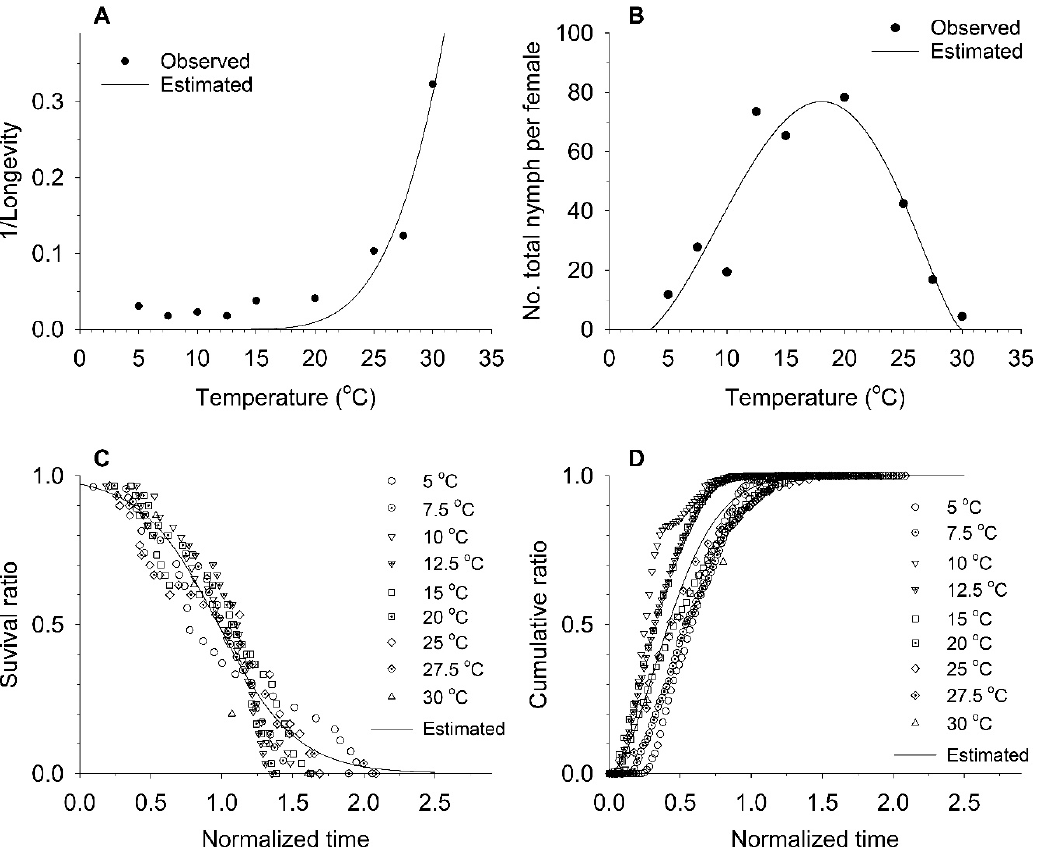
Figure 2. Observed values of the aging rate ( A ), total fecundity ( B ), cumulative survival ratio ( C ), and cumulative fecundity ratio ( D ), and curves estimated from their generalized models (Equation (4), Equation (5), Equation (6), Equation (3)) in A. solani adults.